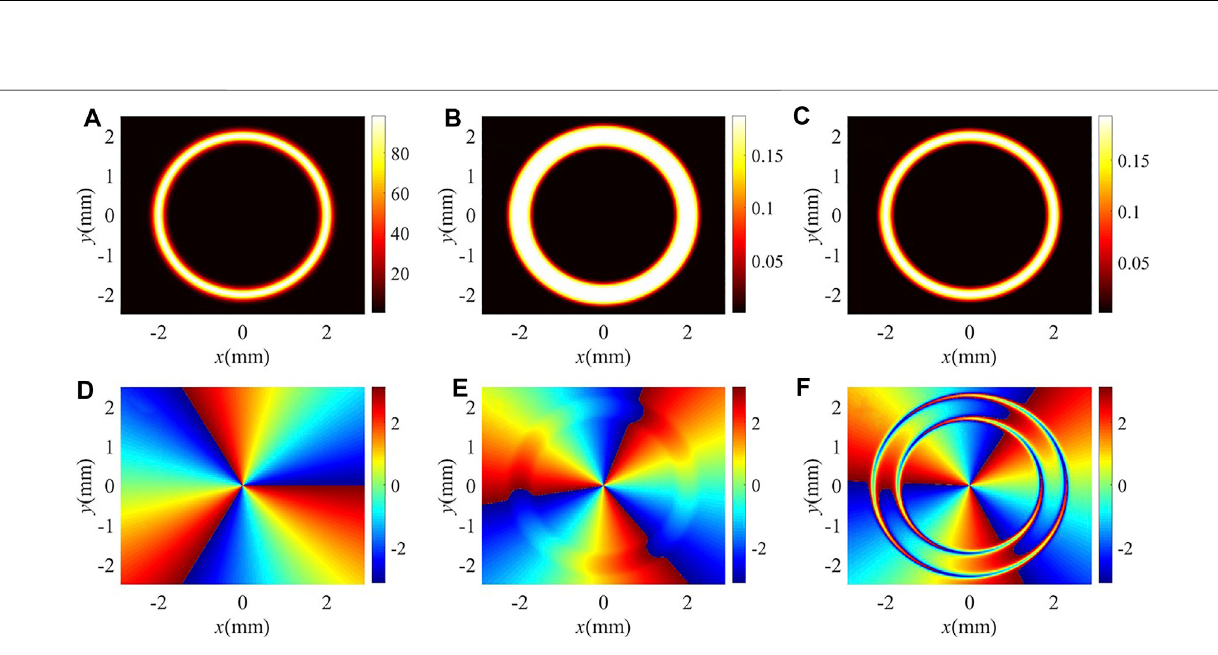
Frontiers in Physics |